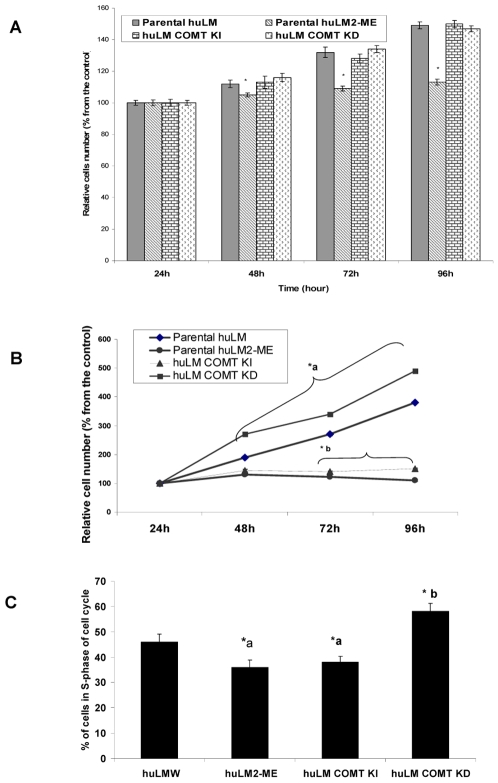
Proliferation and cell cycle progression in huLM2ME, huLM-COMTKI, huLM-COMTKD and huLMW.(A) Proliferation of huLM cells expressing different levels of COMT or treated with 2ME (500 nM) in absence of estrogen. The cells were cultured in phenol red-free medium containing 10% of charcoal-stripped fetal calf serum. MTT assay was used to determine the E2-independent proliferation rates of huLMW, huLM-COMTKD; huLM 2ME, and huLM-COMTKI cells. Cells (1,000/well) were seeded in 96-well microplates. After 24, 48, 72 and 96 hr, the number of viable cells was determined by reading the optical density at a wavelength of 595 nm with a reference wavelength of 650 nm. Data are representative of 3 independent experiments. *a, significantly (P<0.05) lower compared with huLMW. *b, significantly (P<0.05) lower compared with huLMW. (B) E2-induced proliferation of huLM cells expressing different levels of COMT or treated with 2ME (500 nM). Data are representative of 3 independent experiments. *a, significantly (P<0.05) higher compared with huLMW. *b, significantly (P<0.05) lower compared with huLMW. (C) Effects of COMT expression level or treatment with 2ME (500 nM) on E2-provoked huLM cell cycle progression. Flow cytometry using Propidium Iodide labeling of nuclei was done to determine percentage of cells in S-phase of the cell cycle. Data are representative of 3 independent experiments. *a, significantly (P<0.05) lower compared with huLMW. *b, significantly (P<0.05) higher compared with huLMW.